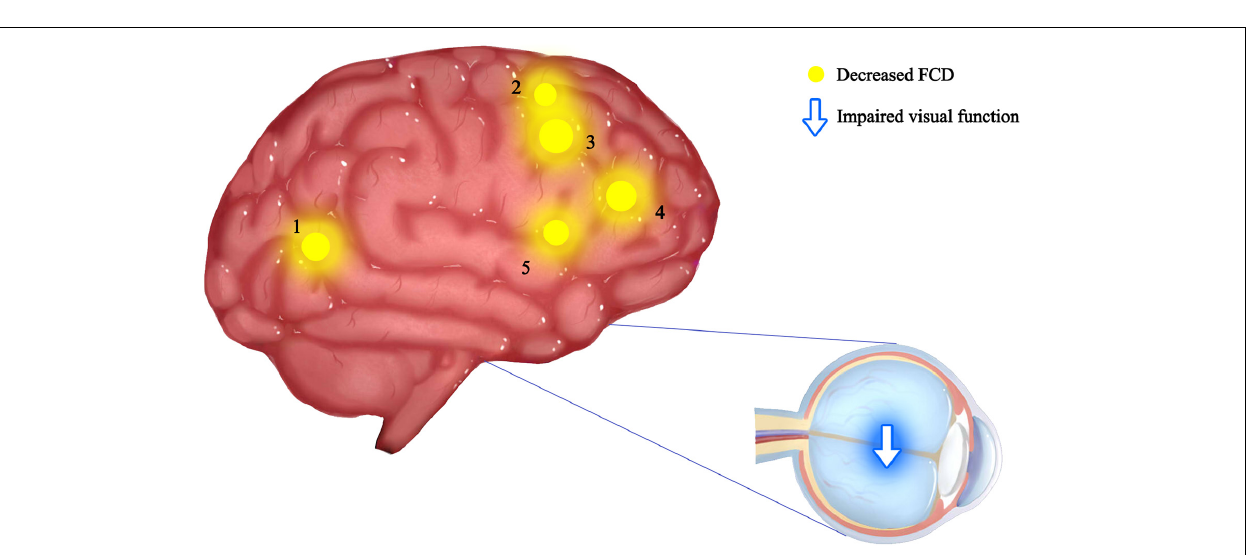
FIGURE 4 | Mean IFCD values of altered brain regions in the ON group. The spot size indicates the extent of change. The IFCD values of the following regions were reduced: 1-middle temporal gyrus (BA32, t = –3.81), 2-angular gyrus (BA44, t = –3.67), 3-cuneus (BA19, t = –3.98), 4-supplementary motor area (BA24, t = –3.78), and 5-supplementary motor area (BA6, t = –3.20). IFCD, short-range functional connectivity density; PAT, patient; HCs, healthy controls; BA, Brodmann’s